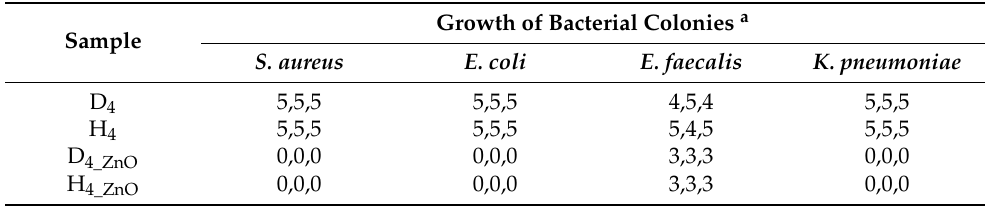
Table 9. Results of antibacterial activity of the coating films of the Series 4.